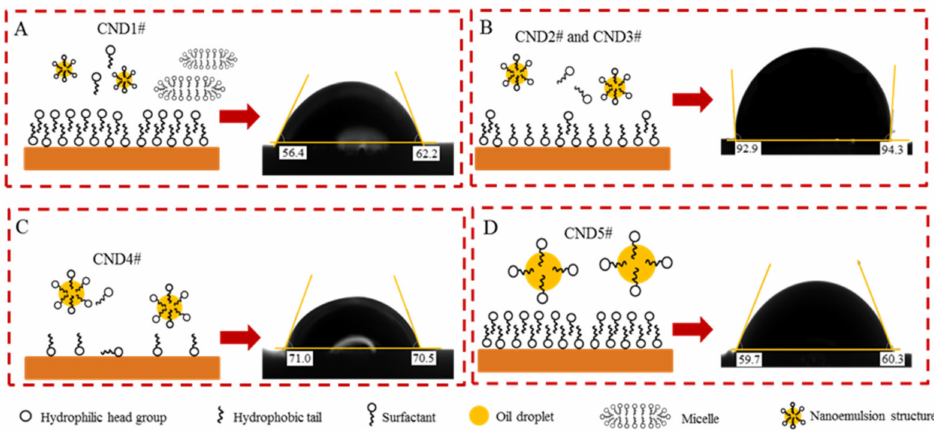
Figure 12. Schematic diagram of nanoemulsions adsorption process ( A ) is the schematic diagram of the adsorption process of CND1#; ( B ) is the schematic diagram of the adsorption process of CND2# and CND3#; ( C ) is the schematic diagram of the adsorption process of CND4#; ( D ) is the schematic diagram of the adsorption process of